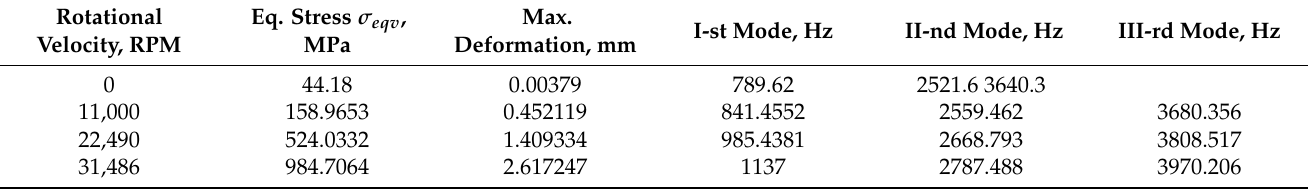
Table 4. Summary of the results of the numerical SAL analysis (with aerodynamic loads